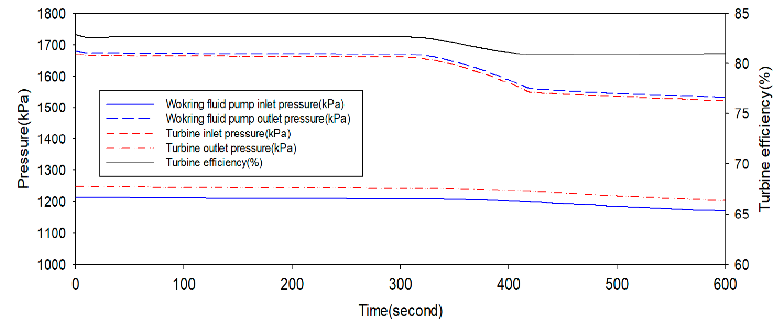
Figure 15. Flow rate gradient of working fluid pump.